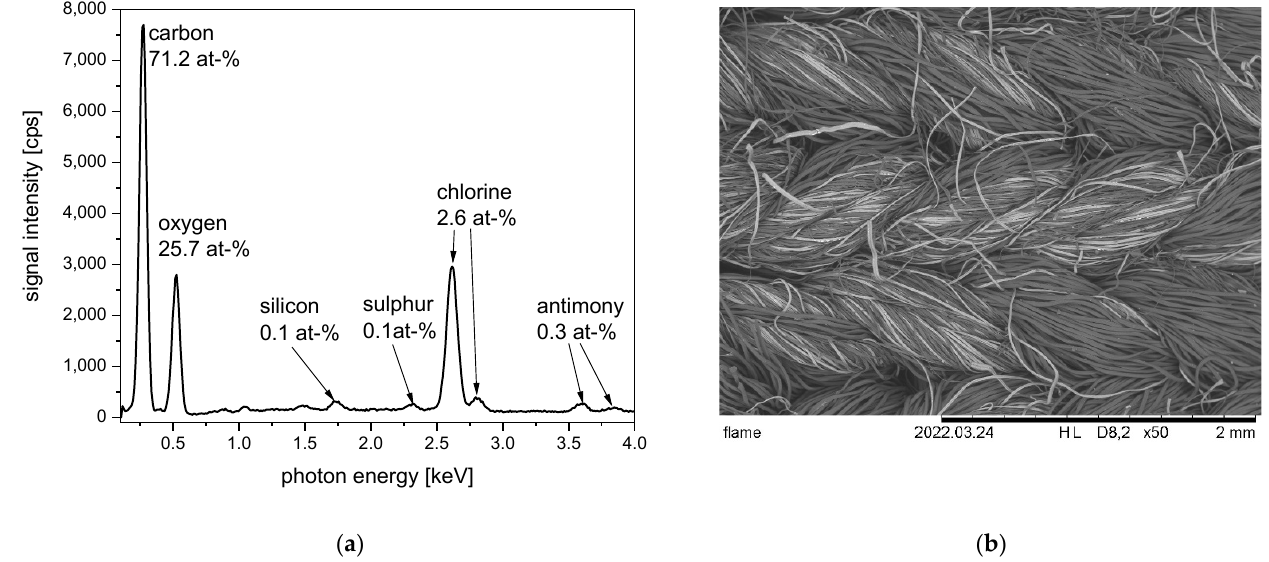
Figure 27. Commercially available flame-retardant belt offered for firefighters—the fiber composition is 23% modacryl, 19% cotton, and 58% polyester (supplier Kübler workwear)—( a ) EDS spectrum; ( b ) SEM image.